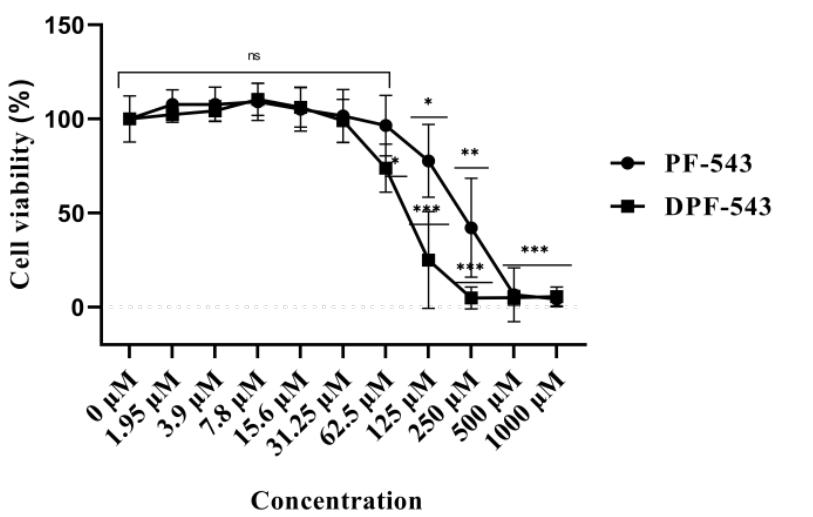
Figure 2. Cell viability of PF-543 and DPF-543 in LLC-PK1 cells. Statistical significance of the data was calculated based on the difference between chemical applied groups and 0 µM treated cells. Data are shown as means ± RSD, ns-not significant, * p < 0.05, ** p < 0.01, *** p < 0.001. 2.2. DPF-543 Activates SPT In Vitro DPF-543 and PF-543 have displayed the specific SPHK inhibition [33]. To clarify a